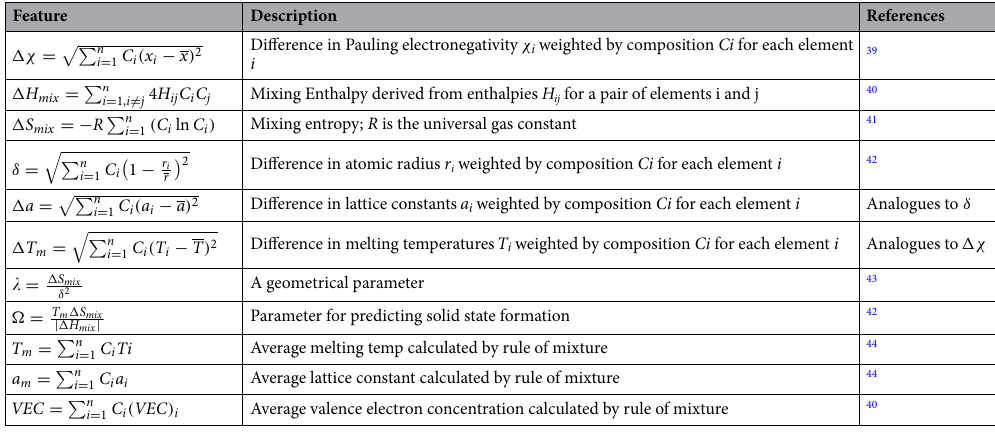
Table 1. Features of alloys considered in this